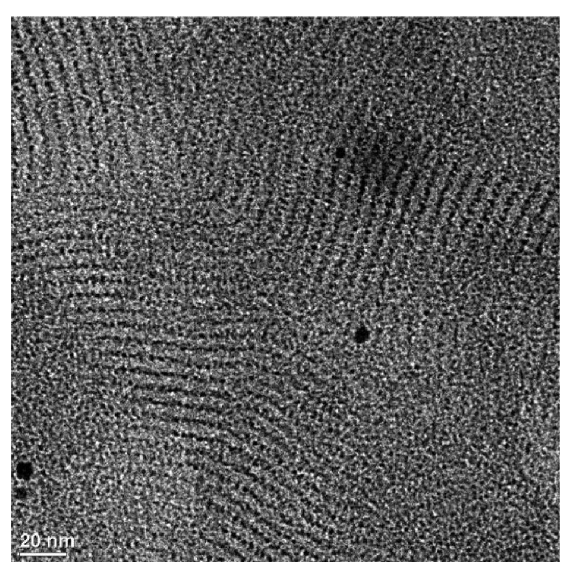
Figure 20: TEM image showing the arrangement of the hybrid NPs Au@16 into regularly spaced rows. Reprinted with permission from [79]. Copyright 2008 Wiley-VCH